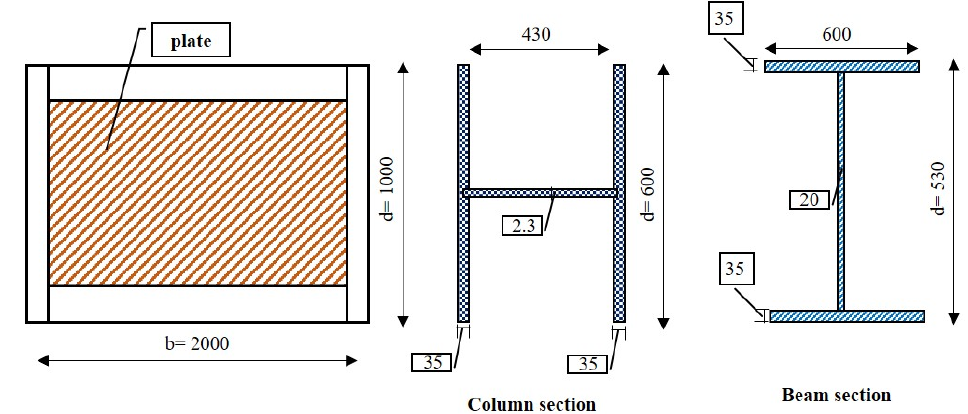
Figure 1. Experimental Specimen Dimensions.